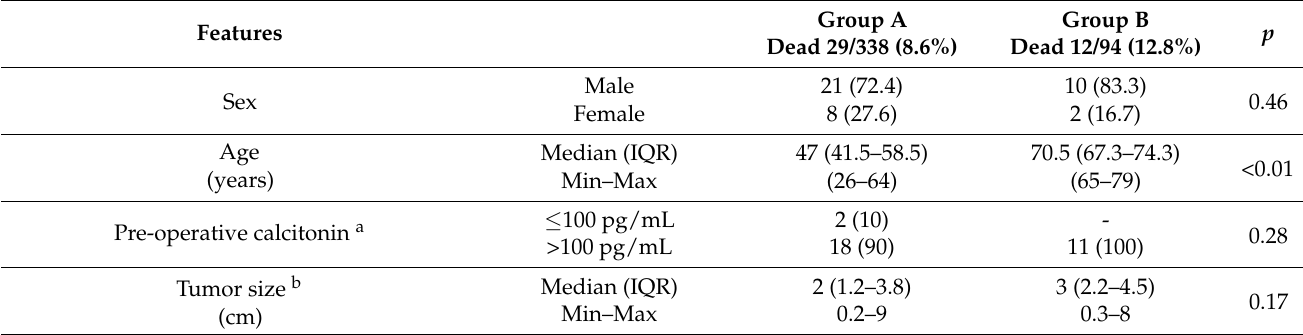
Table 3. Comparison of analyzed features in dead patients of group A and